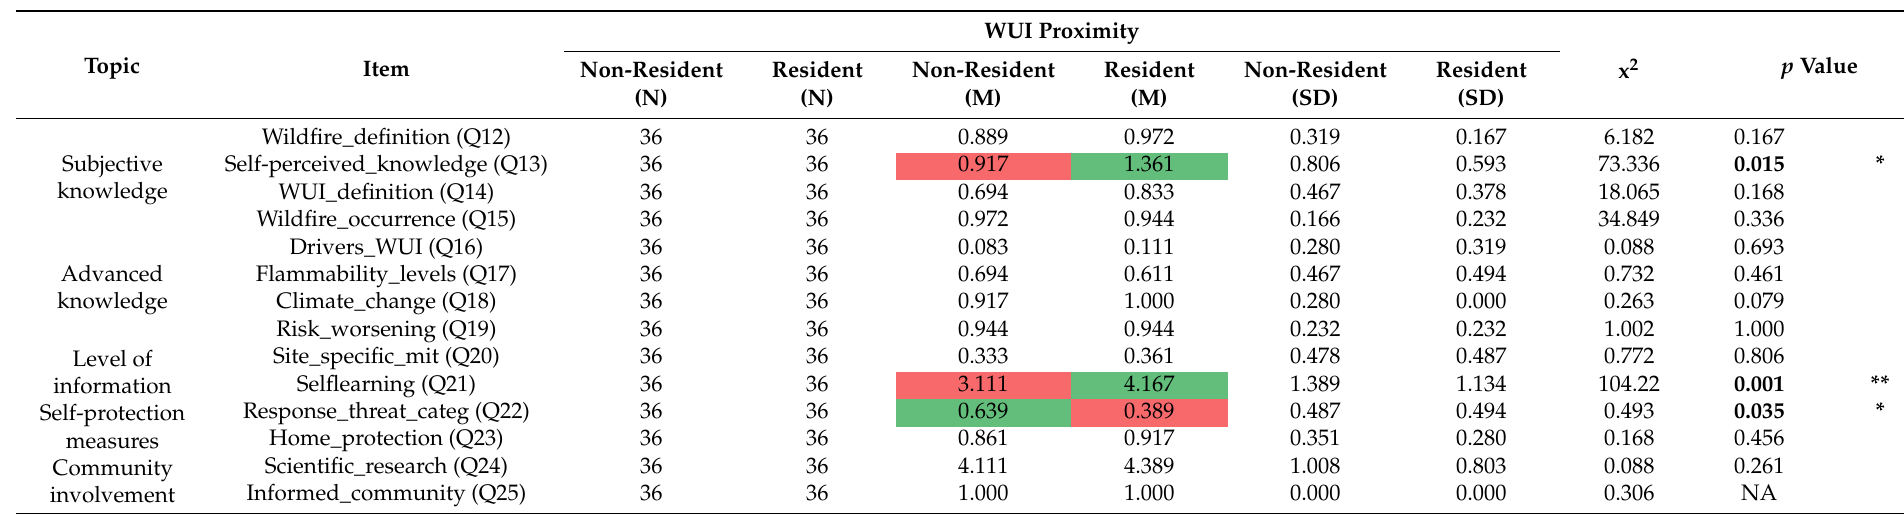
Table 4. Kruskal–Wallis test for differences in responses between the subsamples of non-WUI and WUI residents among participants with direct wildfire